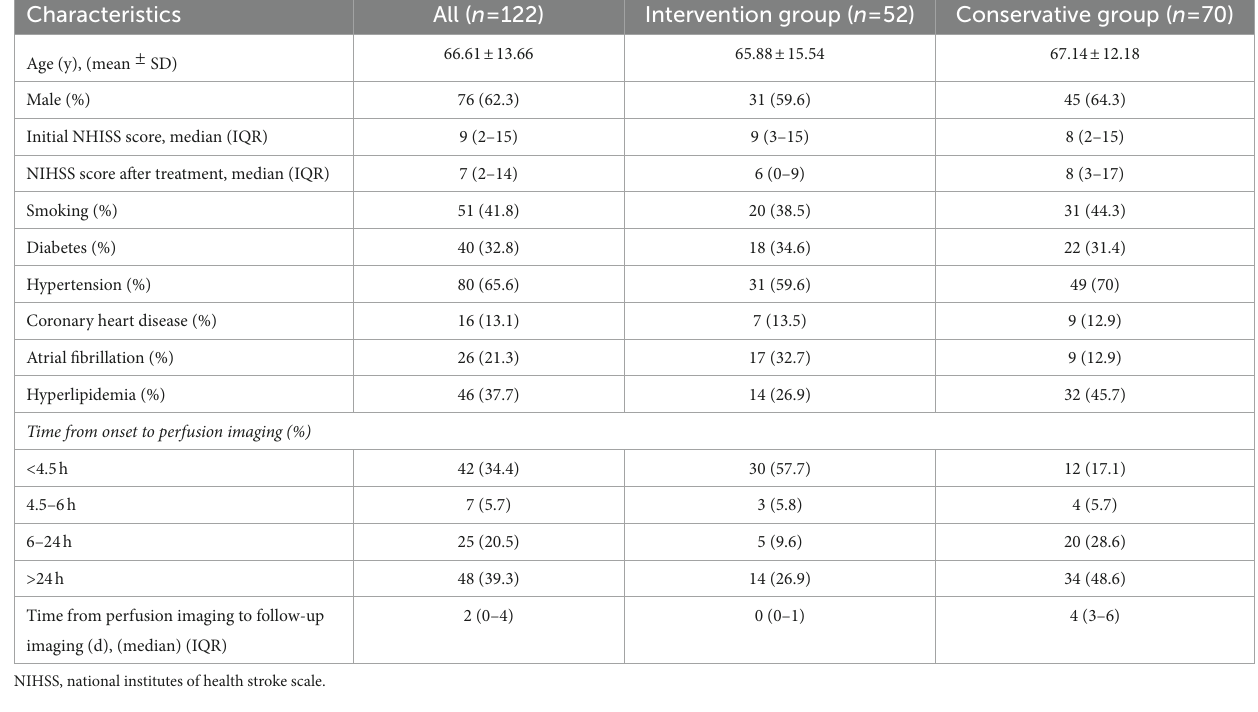
TABLE 1 Baseline demographics and characteristics of all enrolled patients.